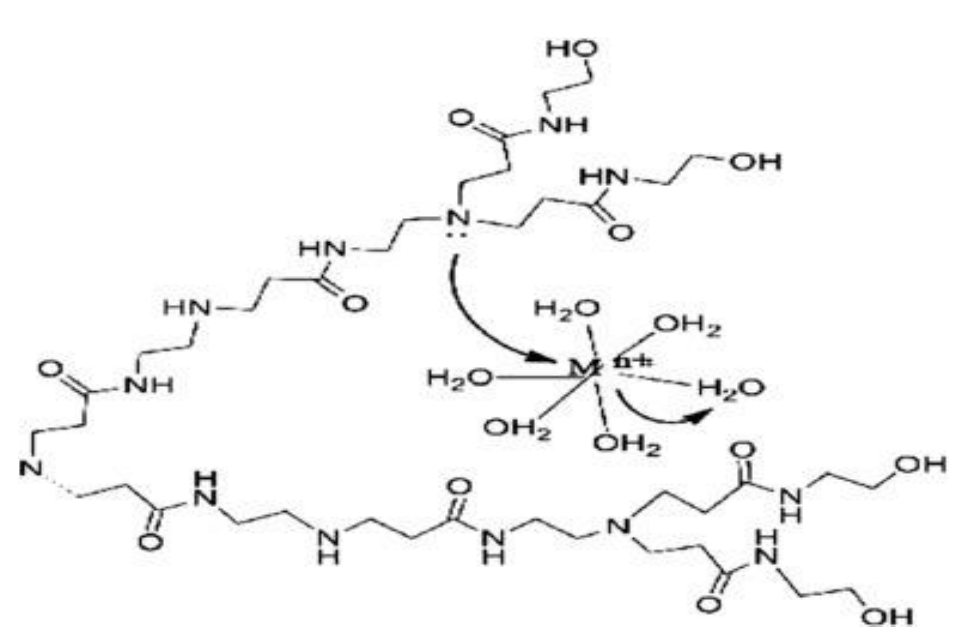
Figure 2. Mechanism for metal cations removal by PAMAM dendrimers–titania composites. Reprinted with permission from [12]. Copyright (2013) Elsevier Ltd.